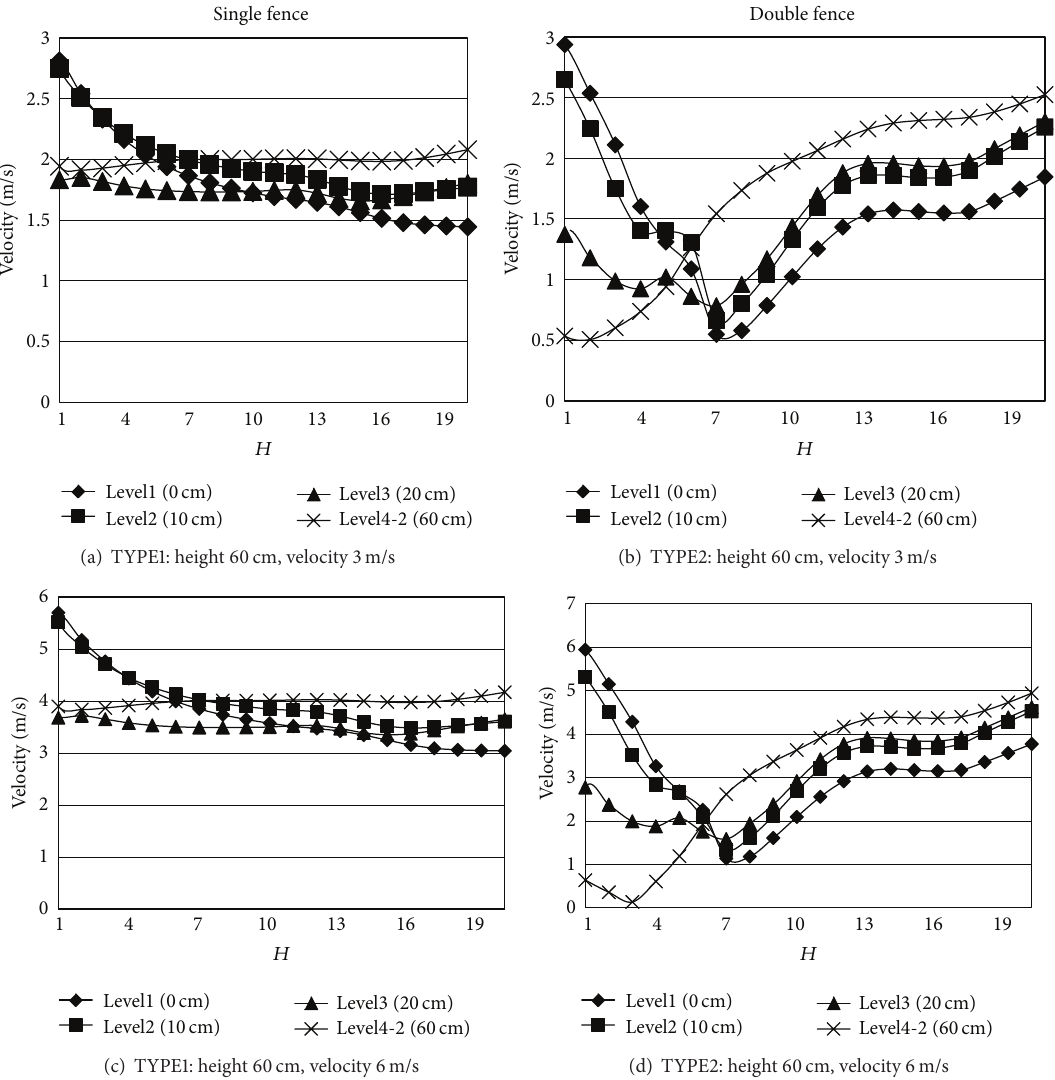
Figure 8: Wind velocity distribution of the linear windbreak fence by distance (Gap 15cm, reference velocity = 3 m/s, 6 m/s).